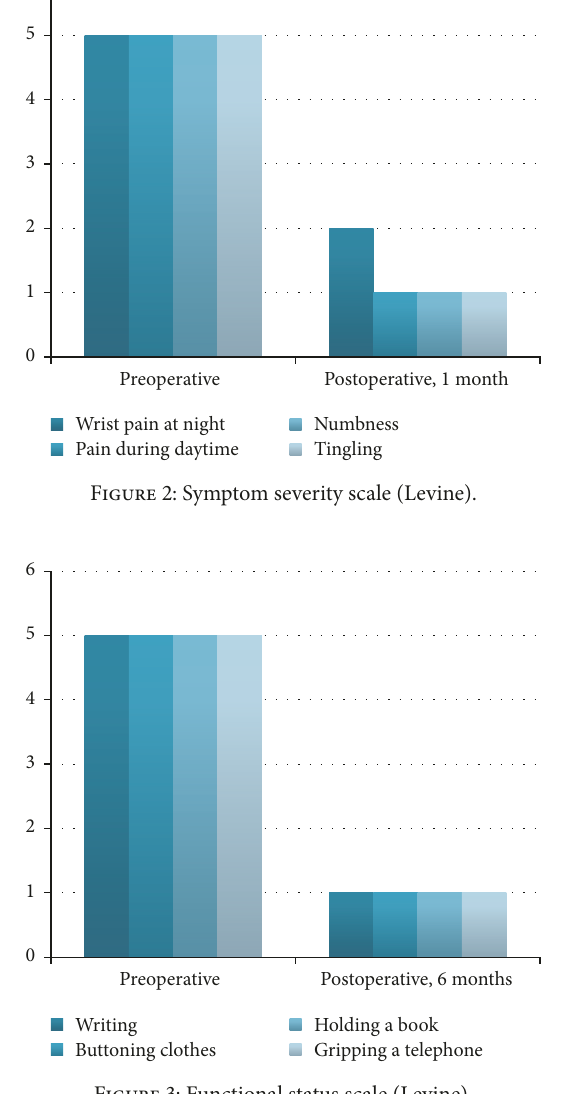
Figure 3: Functional status scale